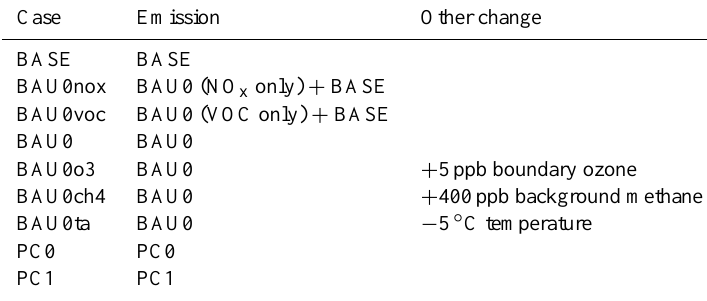
Table 2. Overview of simulation cases performed in this study. Case Emission Other